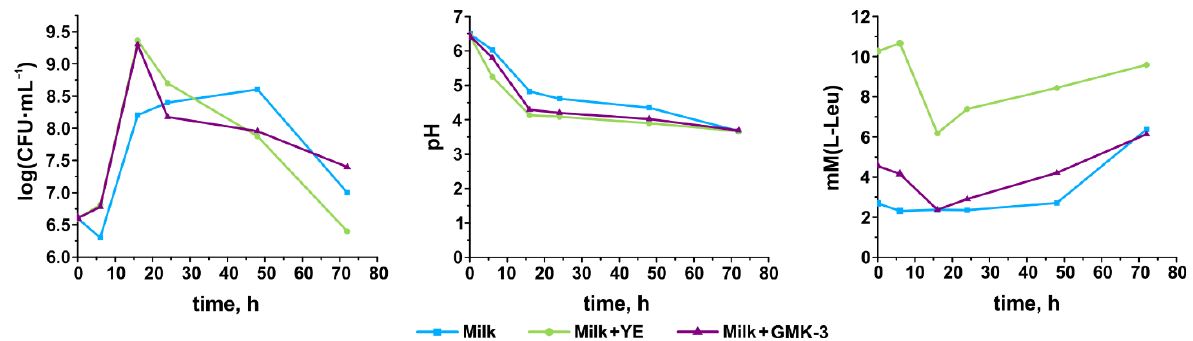
Figure 3. Growth characteristics of B. longum MC-42 on different media: Milk —skim milk; Milk + YE —skim milk with addition of yeast extract, and Milk + GMK-3 —skim milk with addition of hydrolysate containing supplementation GMK-3. The initial values of the degree of proteolysis were 2.74 mM (L-Leu) for Milk, 9.88 mM (L-Leu) for Milk + YE, and 3.77 mM (L-Leu) for Milk + GMK-3.